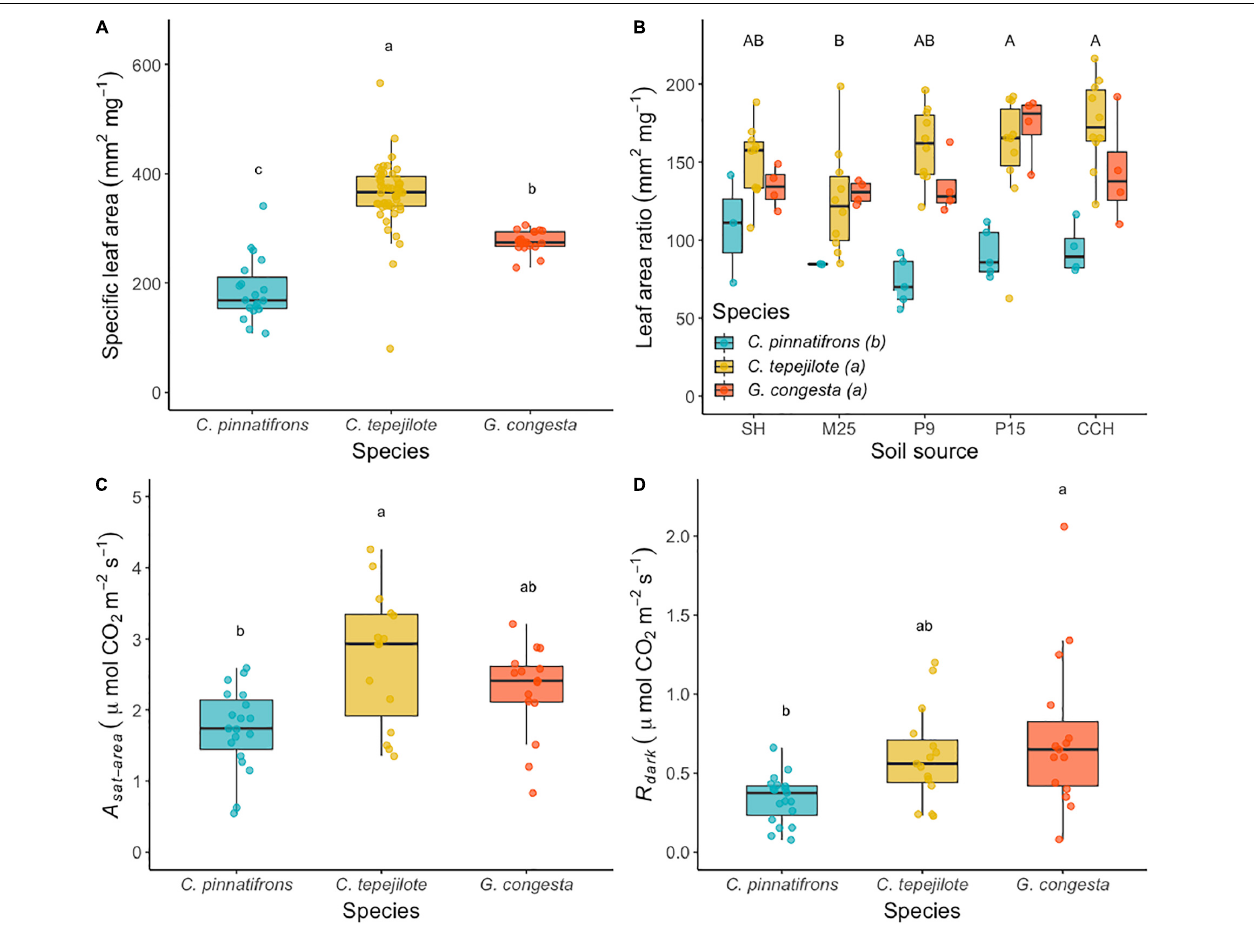
FIGURE 2 | (A) Specific leaf area (SLA), (B) leaf area ratio (LAR), (C) photosynthetic rates (A sat ), and (D) dark respiration rates ( R dark ), in a greenhouse transplant experiment. Boxplots represent median shown by the solid black horizontal line in the middle of each box and bounds represent 25th and 75th percentiles and individual values. Soil is sourced from five sites across a soil nutrient gradient and sites are ranked and listed in order of increasing overall soil nutrient availability. Different letters above the bars and boxplots indicate statistically significant different means according to Tukey’s test ( P < 0.05), with lower case letters representing species differences and capital letters representing soil